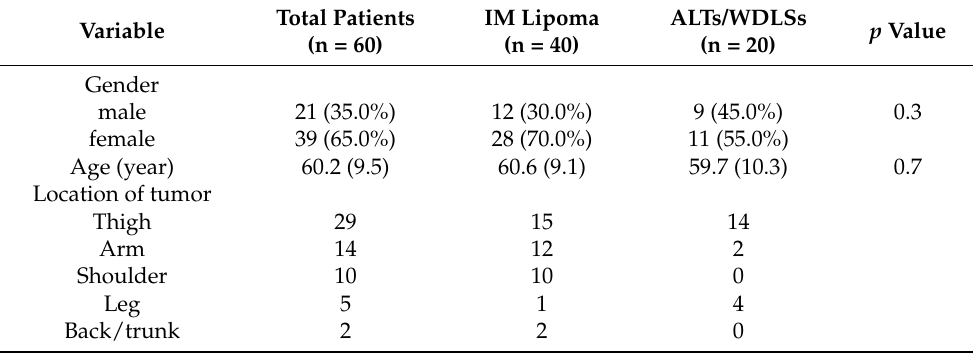
Table 1. Characteristics of patients with lipomatous soft-tissue tumors.